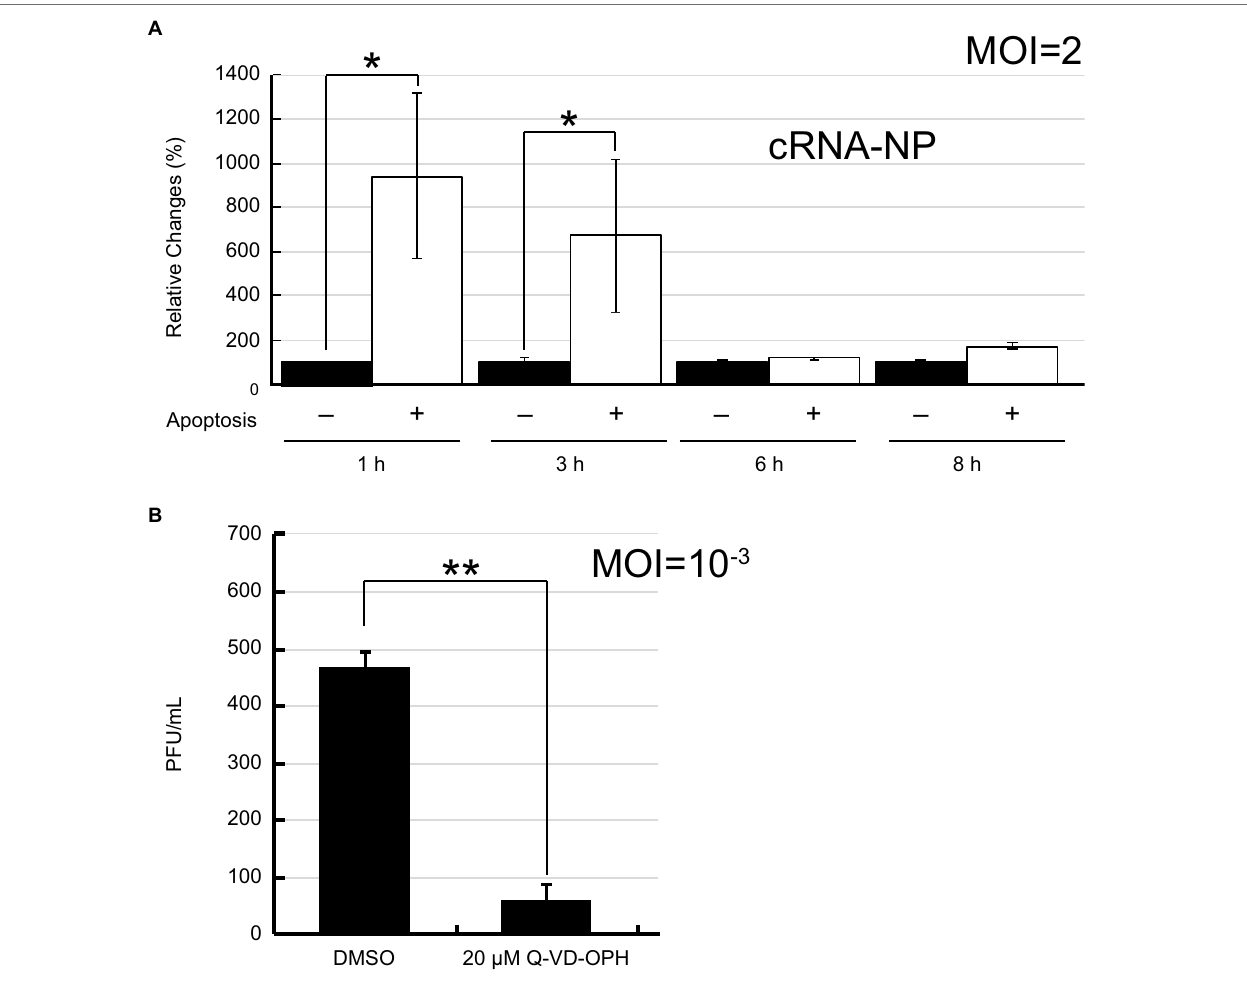
FIGURE 8 | IAV replication in apoptotic cells after infection. (A) A549 cells were infected with PR8 at an MOI of 2. Apoptotic (+) and non-apoptotic ( − ) cells were sorted by flow cytometry after Annexin V staining at the indicated time points post-infection. After isolation of total RNA from the cells, 18S rRNA and NP cRNA (cNP) were quantified by RT-qPCR, after which cRNA levels were normalized to levels of 18S rRNA. The amount of cRNA in non-apoptotic cells was set to 100%. (B) A549 cells were infected with IAV PR8 virus at an MOI of 0.001 and treated with Q-VD-OPH for 24 h. IAV released from cells was collected and quantified by plaque assay. The SD was calculated from two independent sets of experiments. The results were analyzed statistically with Student’s t -test. ** and * represent statistical significance of <0.01 and <0.05,